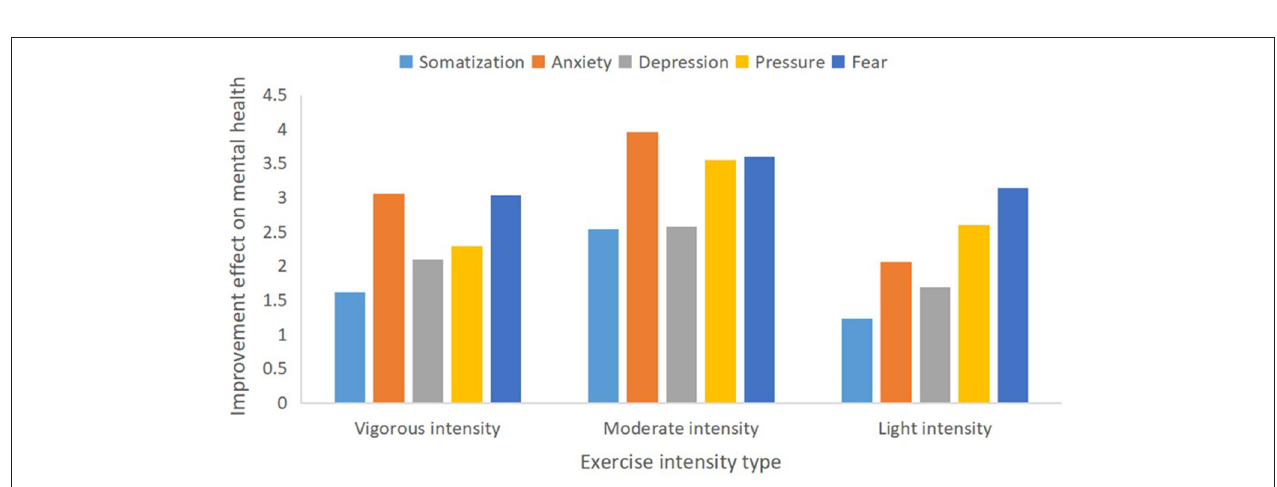
FIGURE 4 | The effect of physical exercise on improving mental health. CC, Chess classes; WR, Walking or running; BV, Basketball, volleyball or football; TS, Taking the stairs; BT, Badminton, tennis or table tennis; RT, Resistance training. MG, Sensory-motor games and whole body vibration; VD, Video dancing; YO, Yoga; CM, Chinese martial arts, Taijiquan and Qigong; RS, Rope skipping or badminton; FG, Family games.